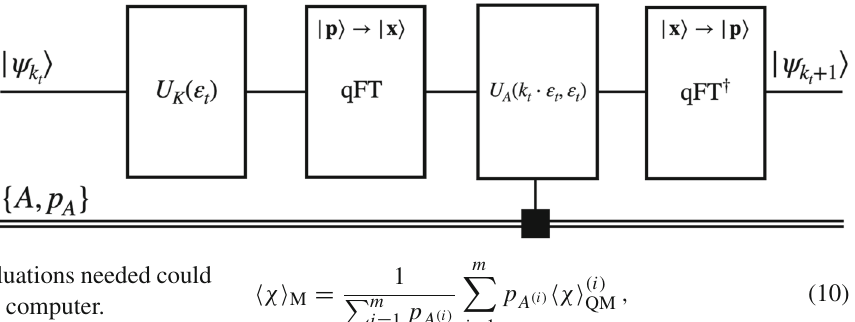
Fig. 2 Outline of the implementation of the time evolution operator U . Here we detail the k th t time step, as indicated in Eq.